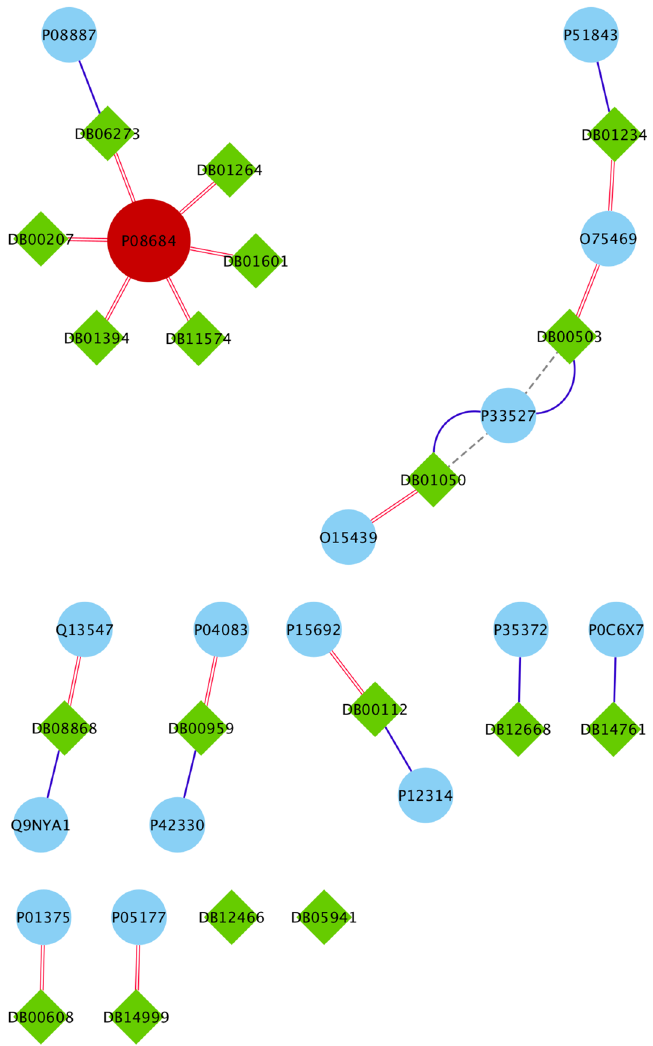
Figure 5. The drug targets in Covid-Drug group for T 2 , L ( Level 1 \ T 2 ), and C ( other proteins of S 2 except S 2 \ L ) sets. The red color node indicates the protein that is the target of a large number of drugs. The red edges, blue edges and black dotted edges are related to L , C and T 2 sets, respectively. The complete description of sets is presented in Table 1.